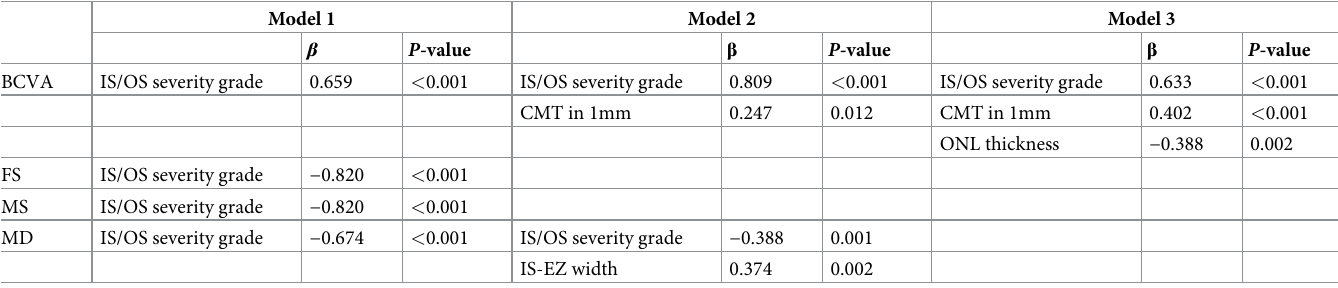
Table 3. Multiple regression analyses of parameters influencing central visual